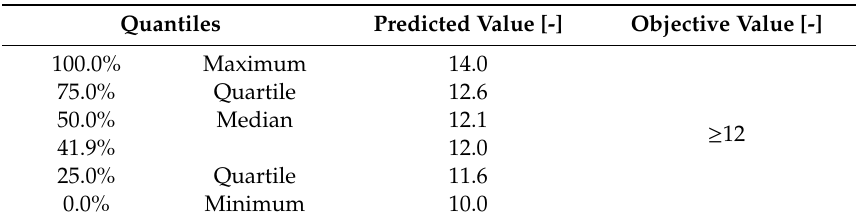
Table 20. L / D cruise percentile.